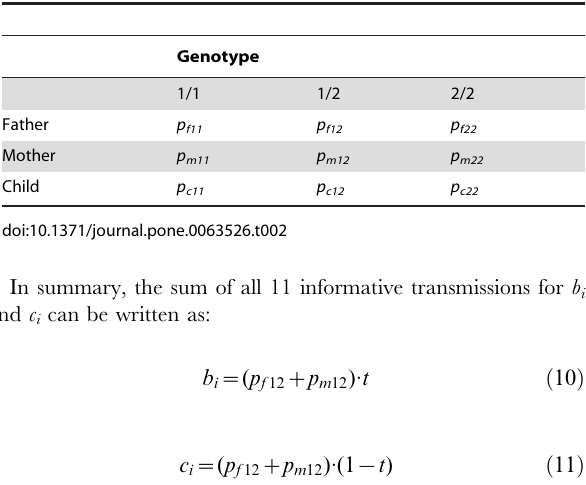
Table 2. Dosage probabilities in a trio (denoted as a trio- dosage set).